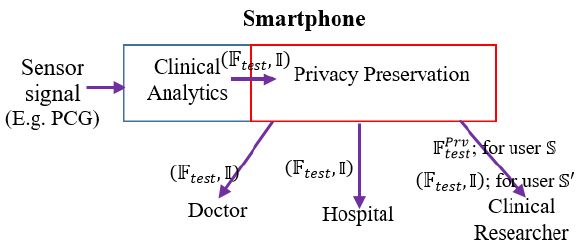
Figure 1. Data-driven on-demand privacy preserved clinical analytics: Functional architecture.